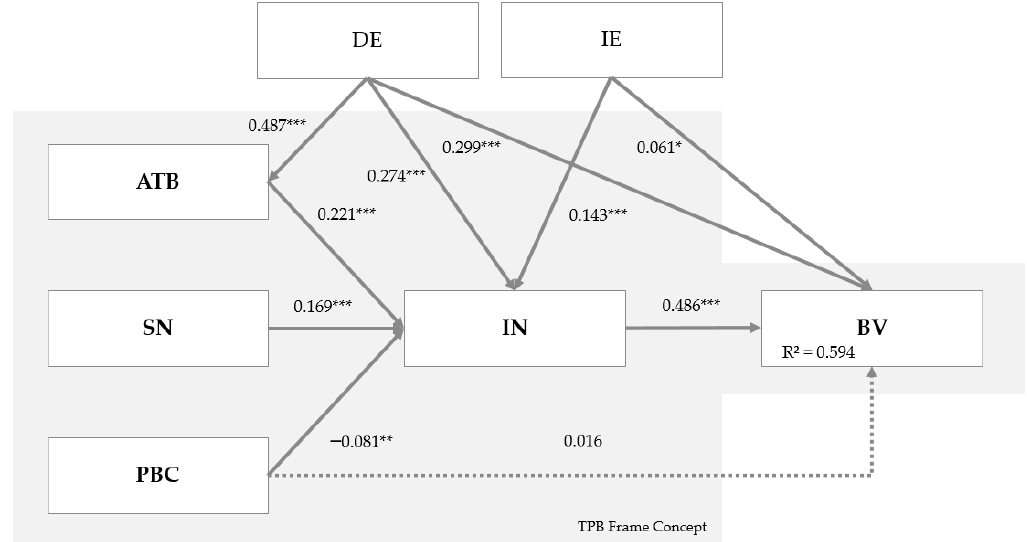
Figure 2. Results of the partial least squares (PLS) analysis: determinants to design and construct pig housing for the improvement of animal welfare. The values are presented as the path coefficients.